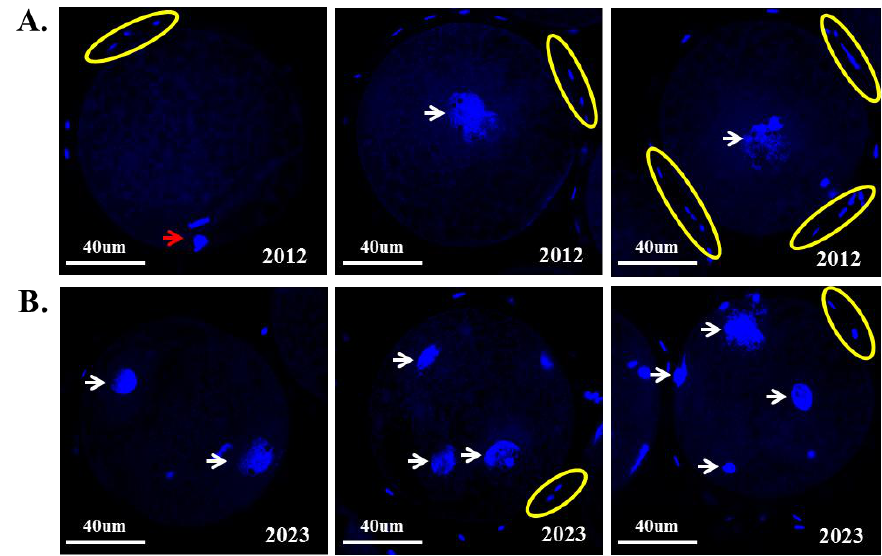
Figure 4. Comparison of pronucleus formation after in vitro fertilization of porcine oocytes. (A) Porcine oocytes in vitro fertilized with sperm from boar number 2012 and (B) 2023. White arrows indicate pronuclei, the red arrow indicates a polar body of unfertilized oocytes, and yellow circles indicate non-fertilized sperm heads containing nucleic acid (4',6-diamidino-2-phenylindole, ×100).